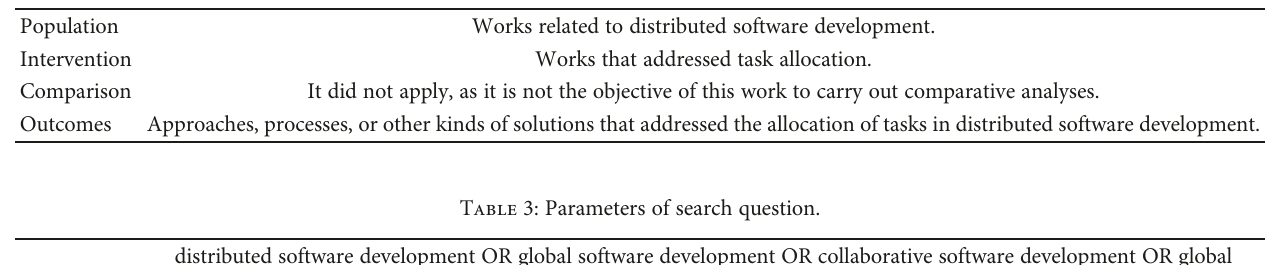
Table 2: Question structure.